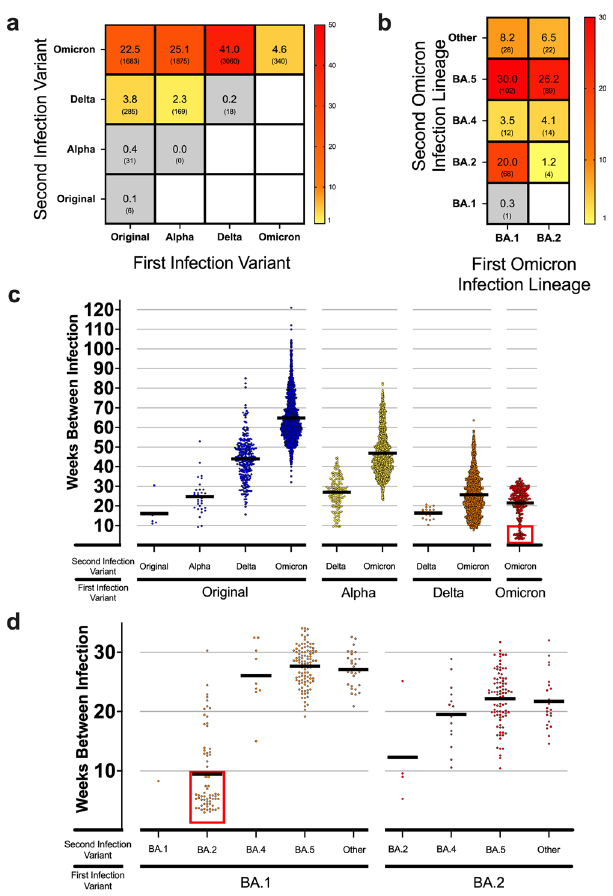
Fig. 1 Reinfection Case Percent and Intervals by Variant. a Heatmap showing the frequency of total reinfections between two variants for both an initial infection and reinfection in Denmark. Raw counts shown below frequency value in parenthesis. No data was available for blank white squares. n = 7467 reinfection cases. b Heatmap showing the reinfection frequency between an initial Omicron infection and a second Omicron infection by sub-linage in Denmark. Raw counts shown below frequency value in parenthesis. No data was available for blank white squares. n = 340 Omicron-to-Omicron reinfection cases. c Scatterplot showing the time between cases (weeks) for the fi rst and second infection of different variants in Denmark. Means of groups are shown with black bars. The red square highlights a number of early Omicron-to-Omicron cases mentioned in the text that occur before a 10-week period. n = 7467 reinfection cases. d Scatterplot for the time between cases (weeks) for Omicron-to-Omicron infections by lineage in Denmark. Means of groups are shown with black bars. The red square highlights early Omicron-to Omicron cases mentioned in the text that occur before a 10-week period for speci fi c sub-lineage. n = 340 Omicron-to-Omicron reinfection